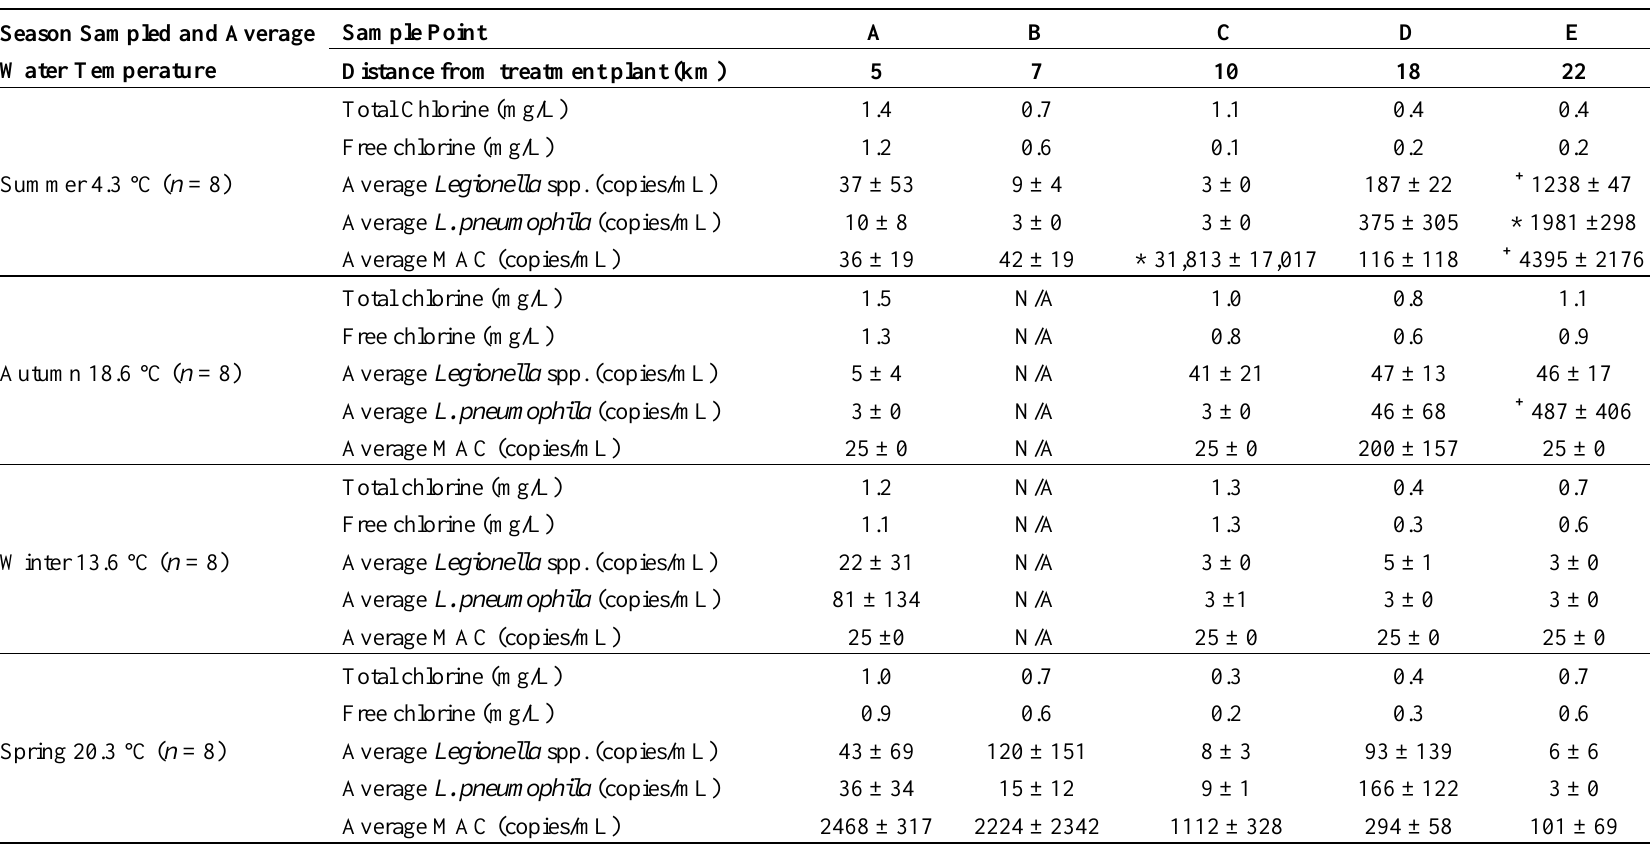
Table 1. Average concentration of Legionella spp. L. pneumophila and MAC (mean ± standard deviation copies/mL) measured at each sampling point of Distribution system 1 (DS1) using qPCR. Total and free chlorine (mg/L) measured when samples were collected is also shown as well as the average water temperature for the month during which the sample was taken. The sampling points where a significant increase ( p < 0.05) in the concentration of an organism compared to the concentration measured at sample point A within the same sampling period are also highlighted